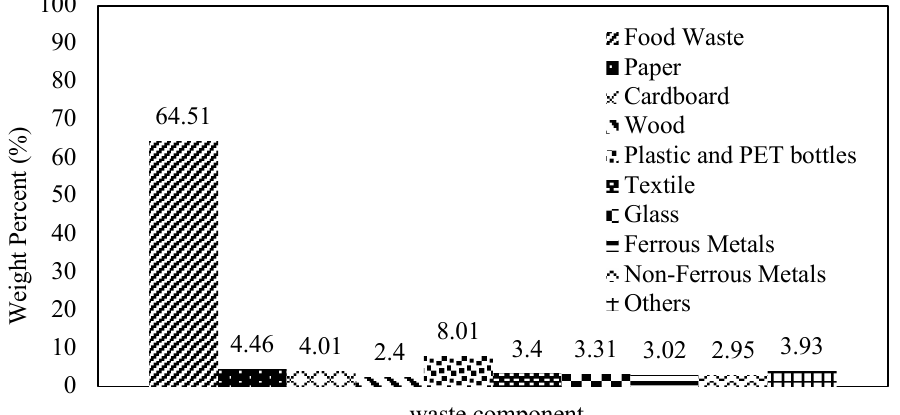
Figure 2. Average frequency chart of waste components for sampling for physical analysis of summer